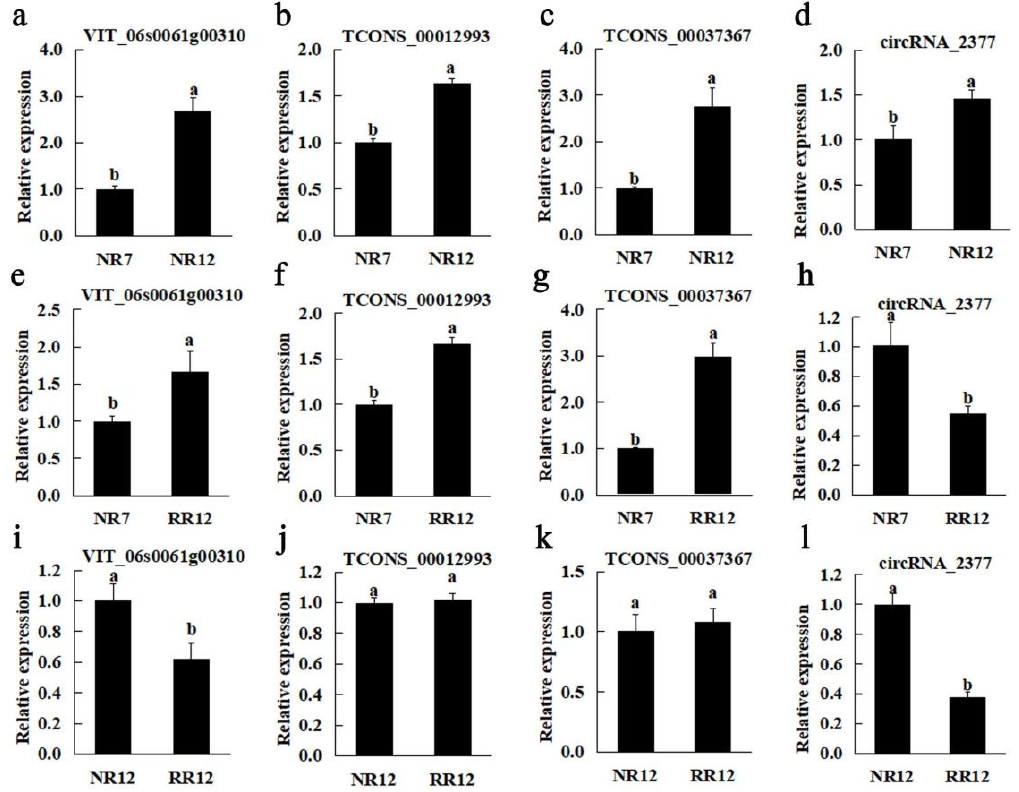
Figure 10. Relative expression analyses of mRNAs, lncRNAs, and circRNAs in the roots of three comparison groups. NR12_vs_NR7 ( a – d ), RR12_vs_NR7 ( e – h ), RR12_vs_NR12 ( i – l ). Significant difference at p < 0.05 is indicated by different letters above the columns.